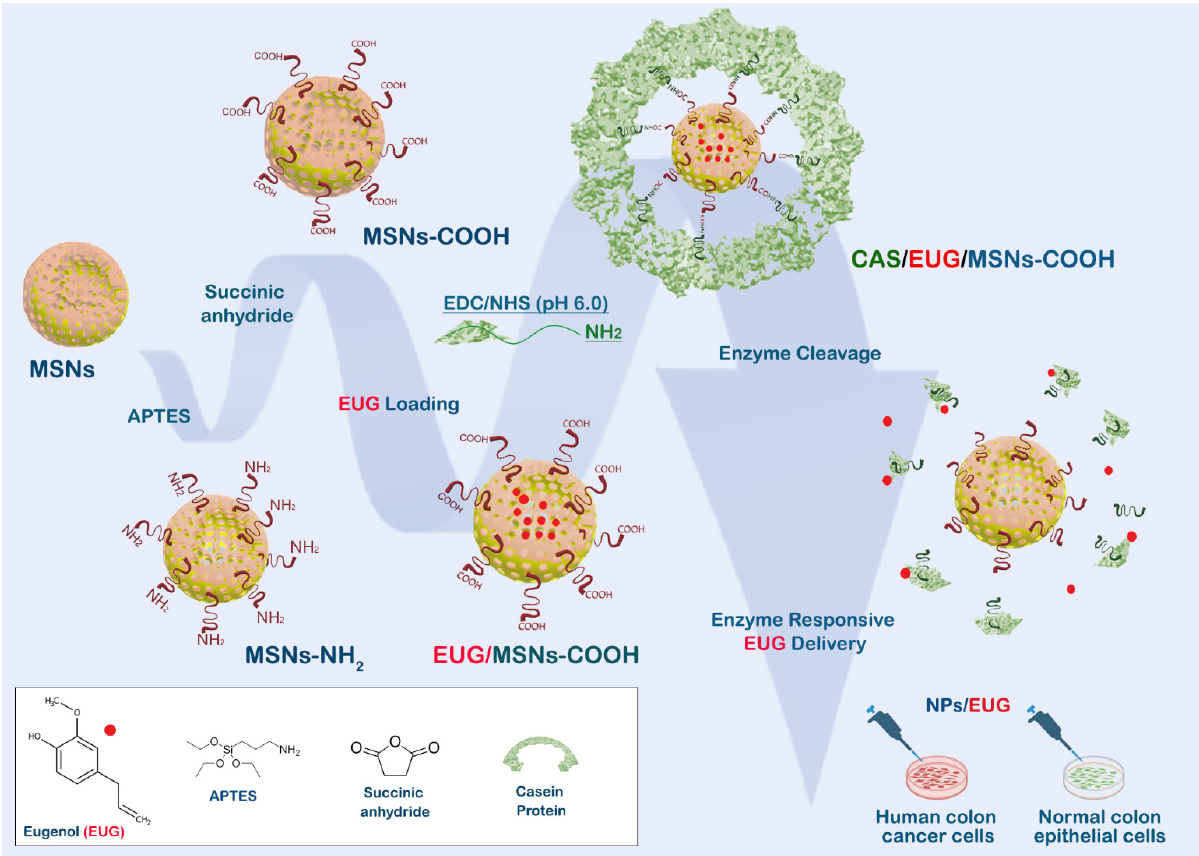
Figure 1. Design and functioning of the nanoassembly for targeting colon cancer cells. MSN is modified by carboxy groups, loaded with EUG, and covalently sealed by casein. Digestion of casein by MMPs released by cancer cells maximizes the toxicity of EUG against cancer cells while protecting healthy cells.